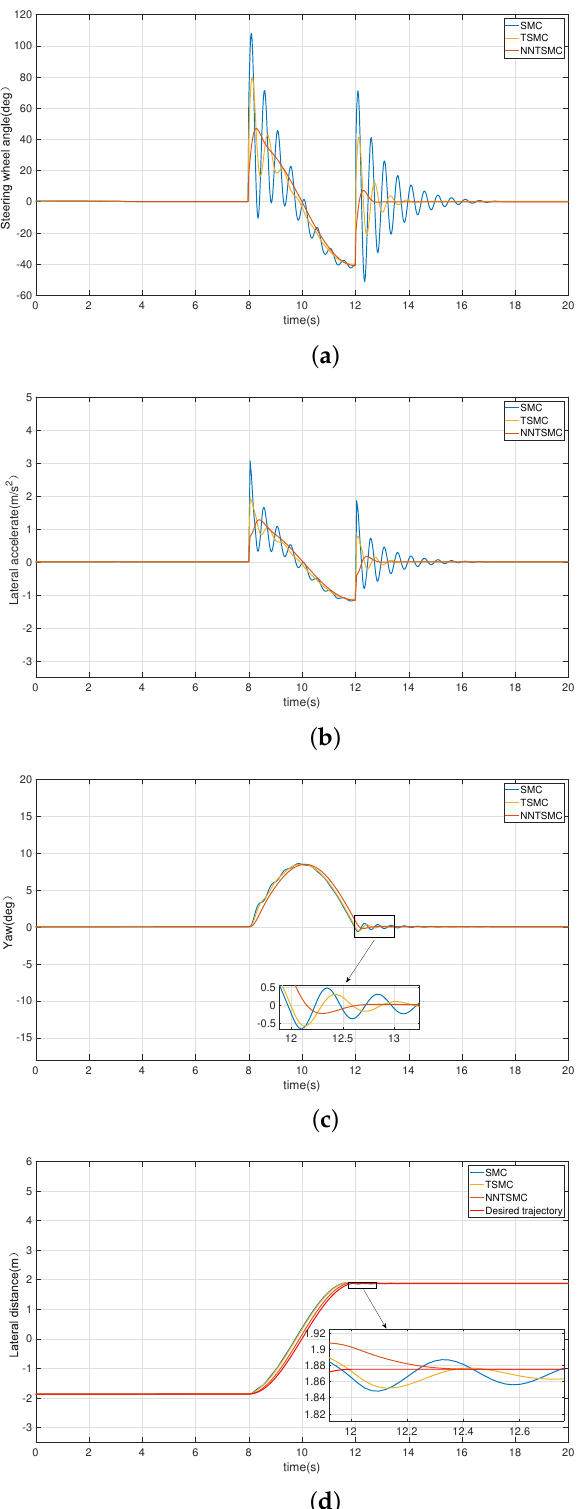
Figure 7. The experimental results of Scenario